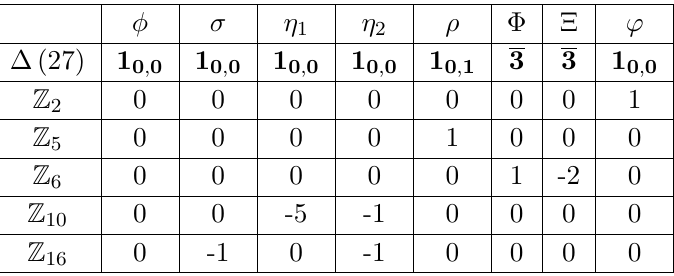
Table 1 . Scalar assignments under (cid:1) (27) the SM SU(2) Higgs doublet. The Z N charges, q , shown in the additive notation so that the group element is ! = e 2 (cid:25)iq=N . For the (cid:1)(27) representations and the notations see appendix A.